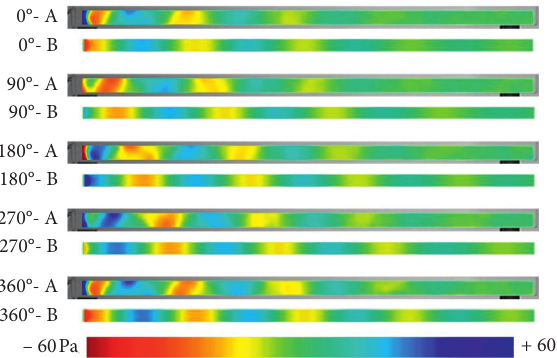
Figure 7: Quantified time evolution of longitudinal stress wave at 20kHz [33]. (a) Experimental value. (b) FEA